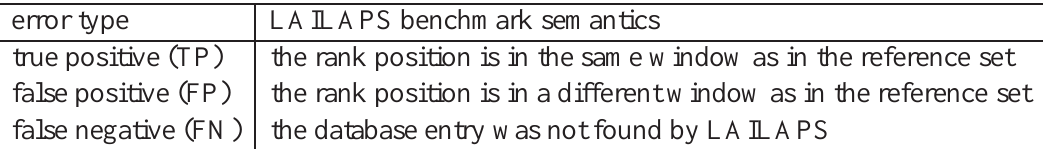
Table 3: Definition of evaluation error types.